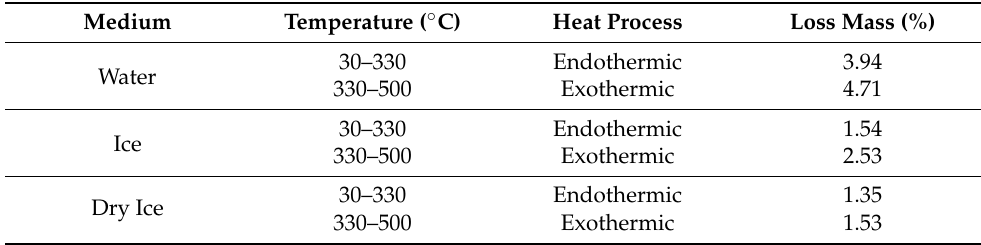
Table 1. DTA/TGA